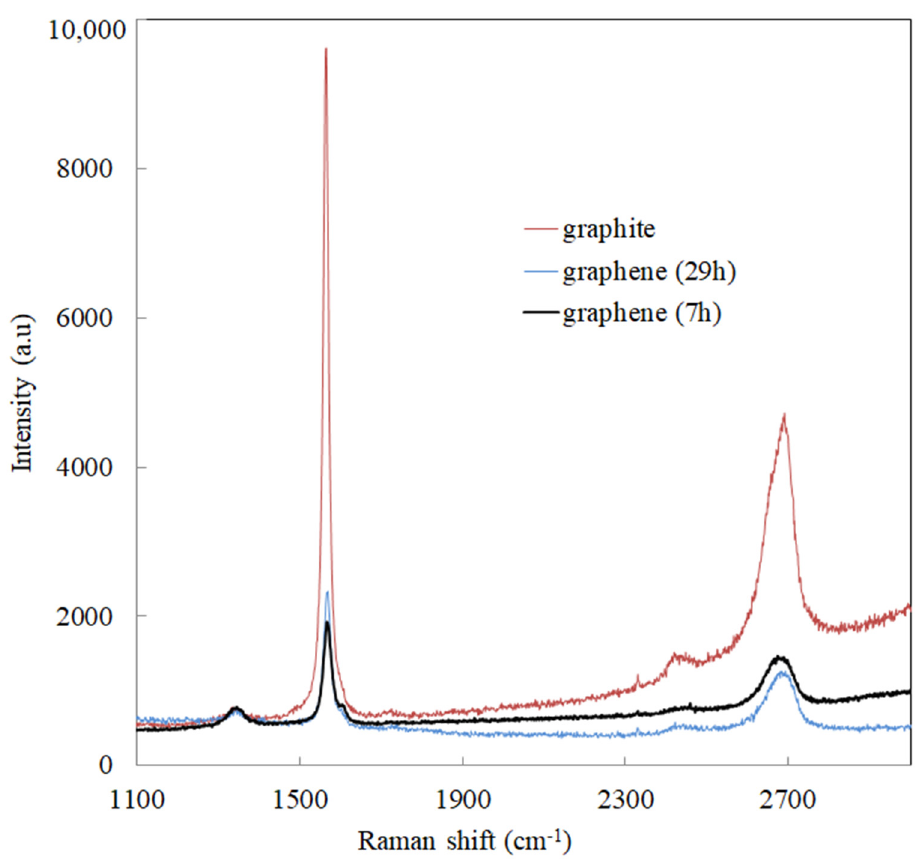
Figure 8. Raman shift for graphite and graphene. Raman spectra of G showing few-layer graphene (7 h and 29 h) and starting graphite for reference.